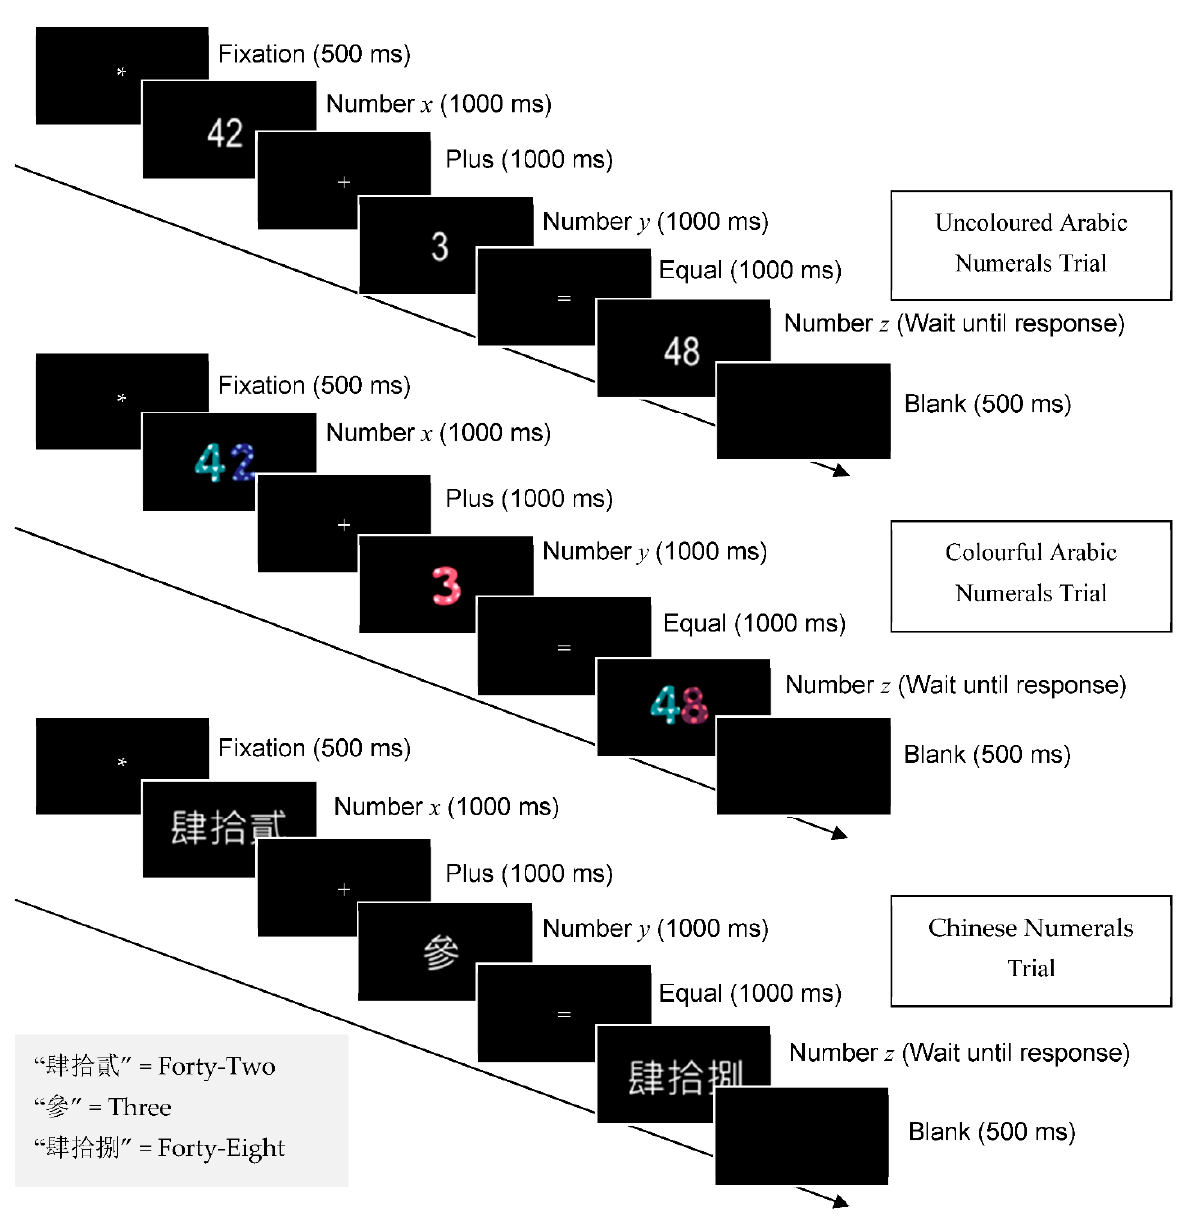
Figure 1. Schematic representations of the conditionwise trials and their respective timings for the uncoloured Arabic numerals trial ( top ), colourful Arabic numerals trial ( middle ), and Chinese numerals trial ( bottom ). See the text for further details.